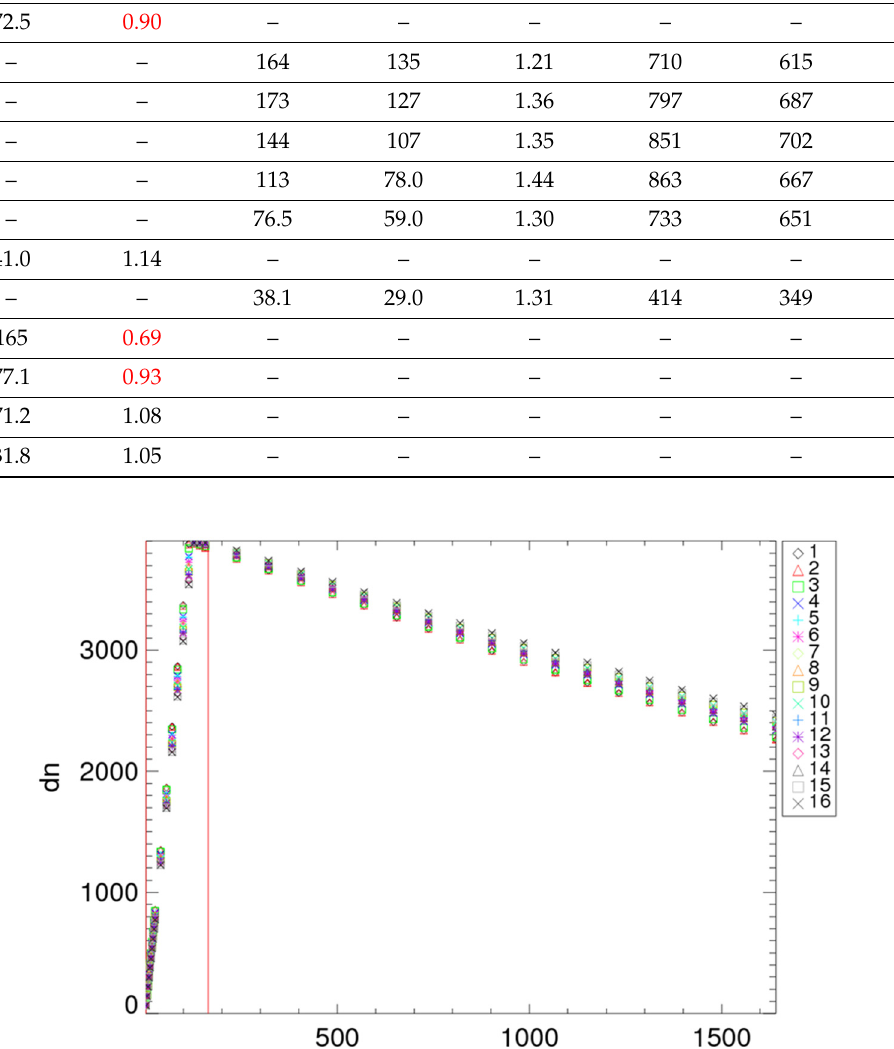
Figure 8. Band I3 dynamic range measurements for all detectors, legend on the right, for HAM side B. The y -axis is offset subtracted VIIRS response, and the x -axis is the SIS100 radiance during the measurement. The vertical red line corresponds to Lmax, and the saturation occurs before the line. The rollover in the response is due to saturation of the focal plane electronics. This causes two unique radiance levels to produce the same VIIRS digital number. The blue crosses are from detector 4 that is an out of family with degraded performance that has continued on orbit.